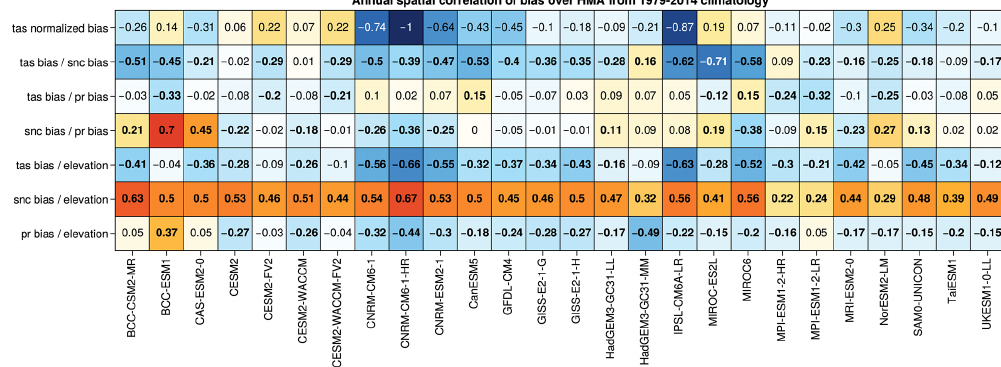
Figure C1. Same as Fig. 4 but with GPCP total precipitation observations instead of APHRODITE.